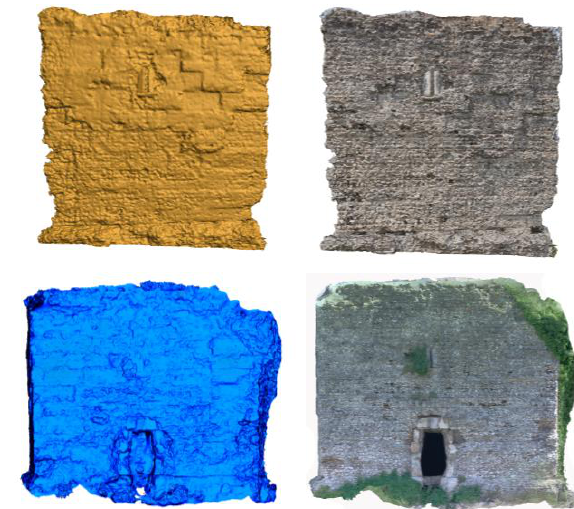
Figure 6. The mausoleum’s model imported in